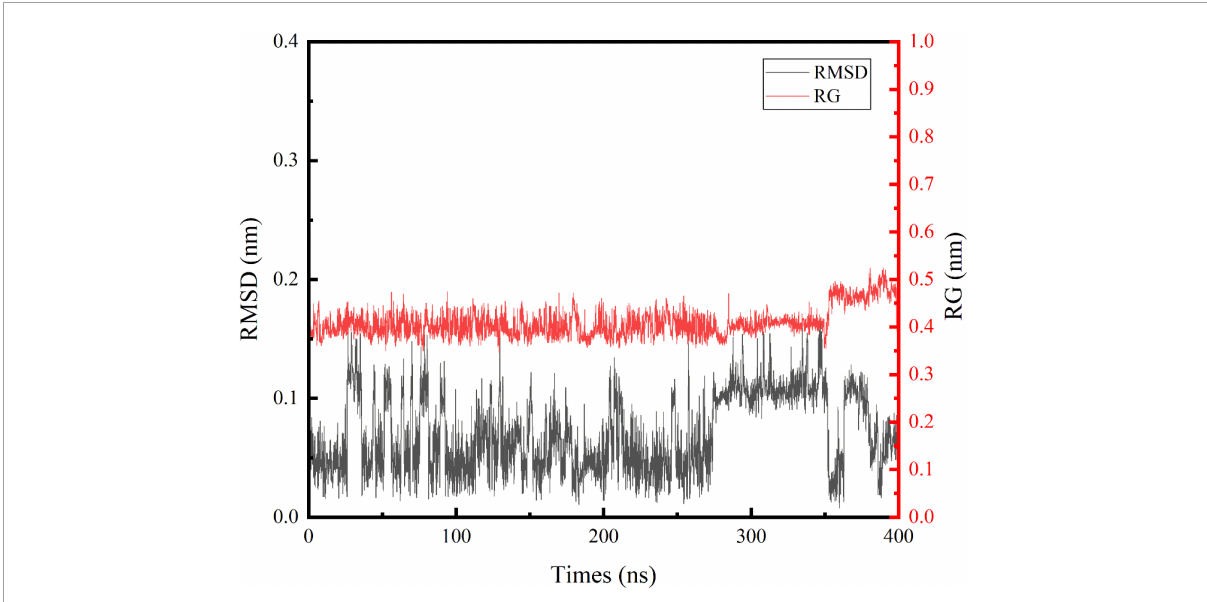
FIGURE1 Time evolution of the backbone RMSD and Rg of the tripeptide NCW during the 400 ns MD